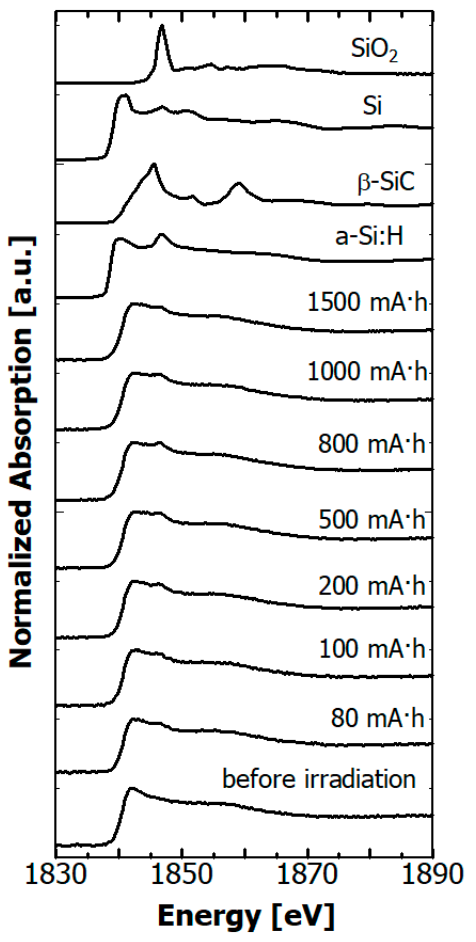
Figure 11. Dependence of Si K edge NEXAFS spectra of hydrogenated Si-DLC films on SR dose, together with those of SiO 2 powder, Si wafer, β -SiC powder, and a-Si:H film. The Si- L edge NEXAFS spectra of the hydrogenated Si-DLC film before and after film, and β -SiC powder. In the spectra of the Si wafer and a-Si:H film, peaks derived from